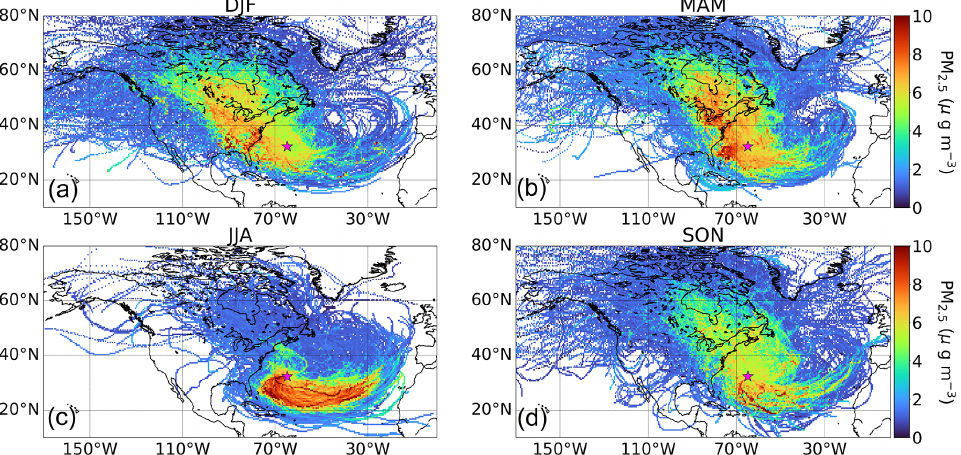
Figure 2. Seasonal (a–d) concentration-weighted trajectory maps (CWTs) for PM 2 . 5 measured at Fort Prospect in Bermuda, denoted by the pink star. This analysis is based on trajectories between 1 January 2015 and 31 December